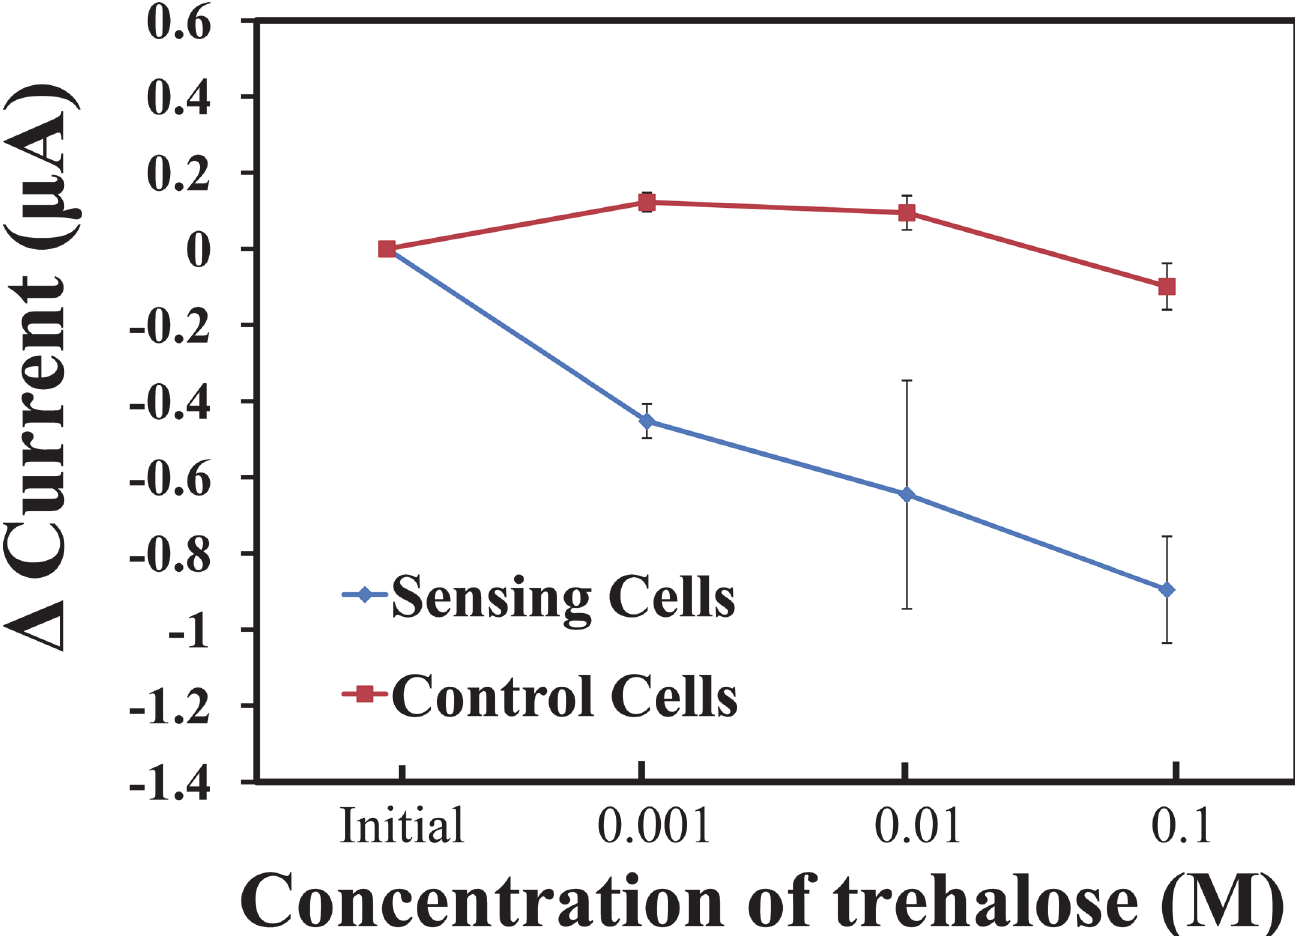
Fig 4. EG-ISFET biosensor response currents of cells reacting to trehalose. The change of current determined with the EG-ISFET sensor is represented as a function of trehalose concentration. The sensing cells depicted as closed red squares, whereas the control cells are shown as closed blue